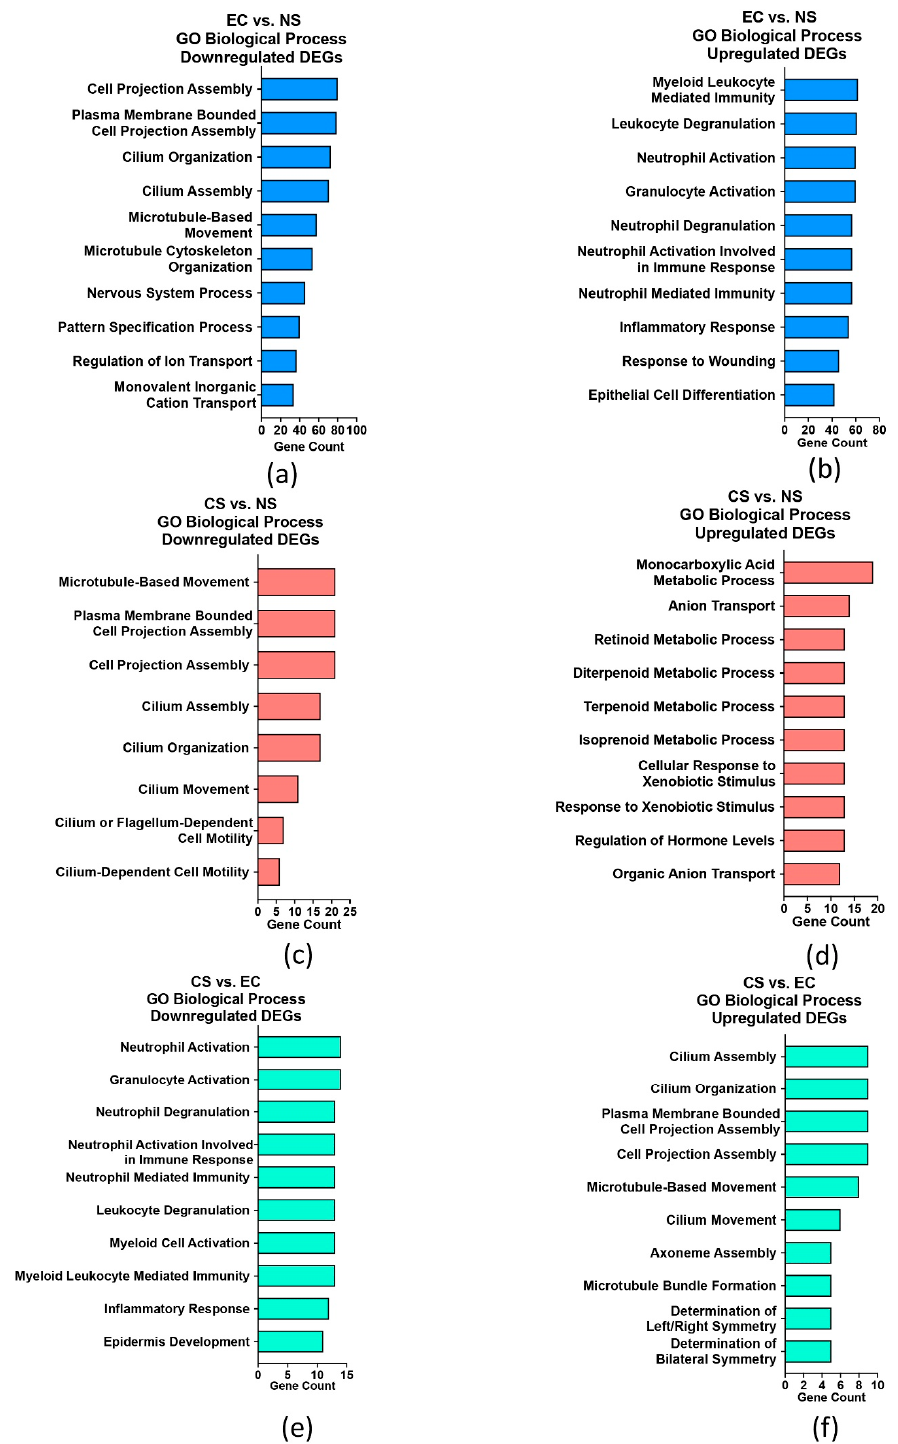
Figure 2. Top 10 enriched GO term annotations for each comparison. ( a ) Enriched downregulated biological processes in the EC vs. NS set. ( b ) Enriched upregulated biological processes in the EC vs. NS set. ( c ) Enriched downregulated biological processes in the CS vs. NS set. ( d ) Enriched upregulated biological processes in the CS vs. NS set. ( e ) Enriched downregulated biological processes in the CS vs. EC set. ( f ) Enriched upregulated biological processes in the CS vs. EC set. (FDR < 0.05). Biological processes were mainly related to cilia assembly (EC, CS) and immune response